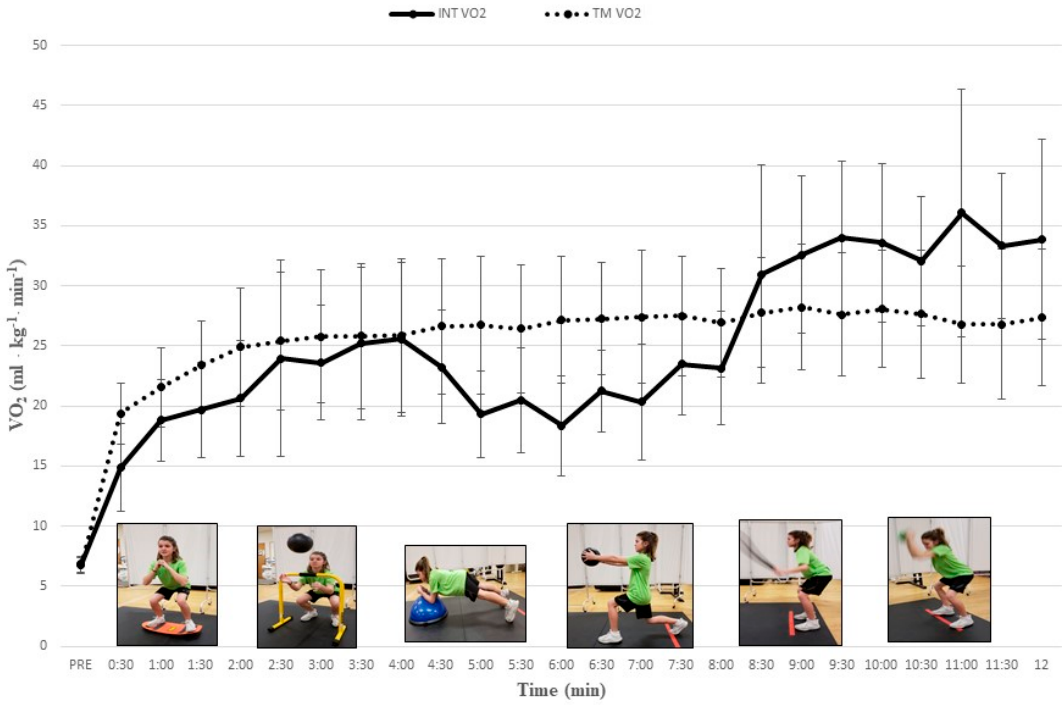
Figure 2. Relative oxygen uptake responses (mean ± SD) during integrative neuromuscular training (INT) and treadmill (TM) protocols. PRE = Baseline; See Table 1 for significant differences between INT exercises and protocols.